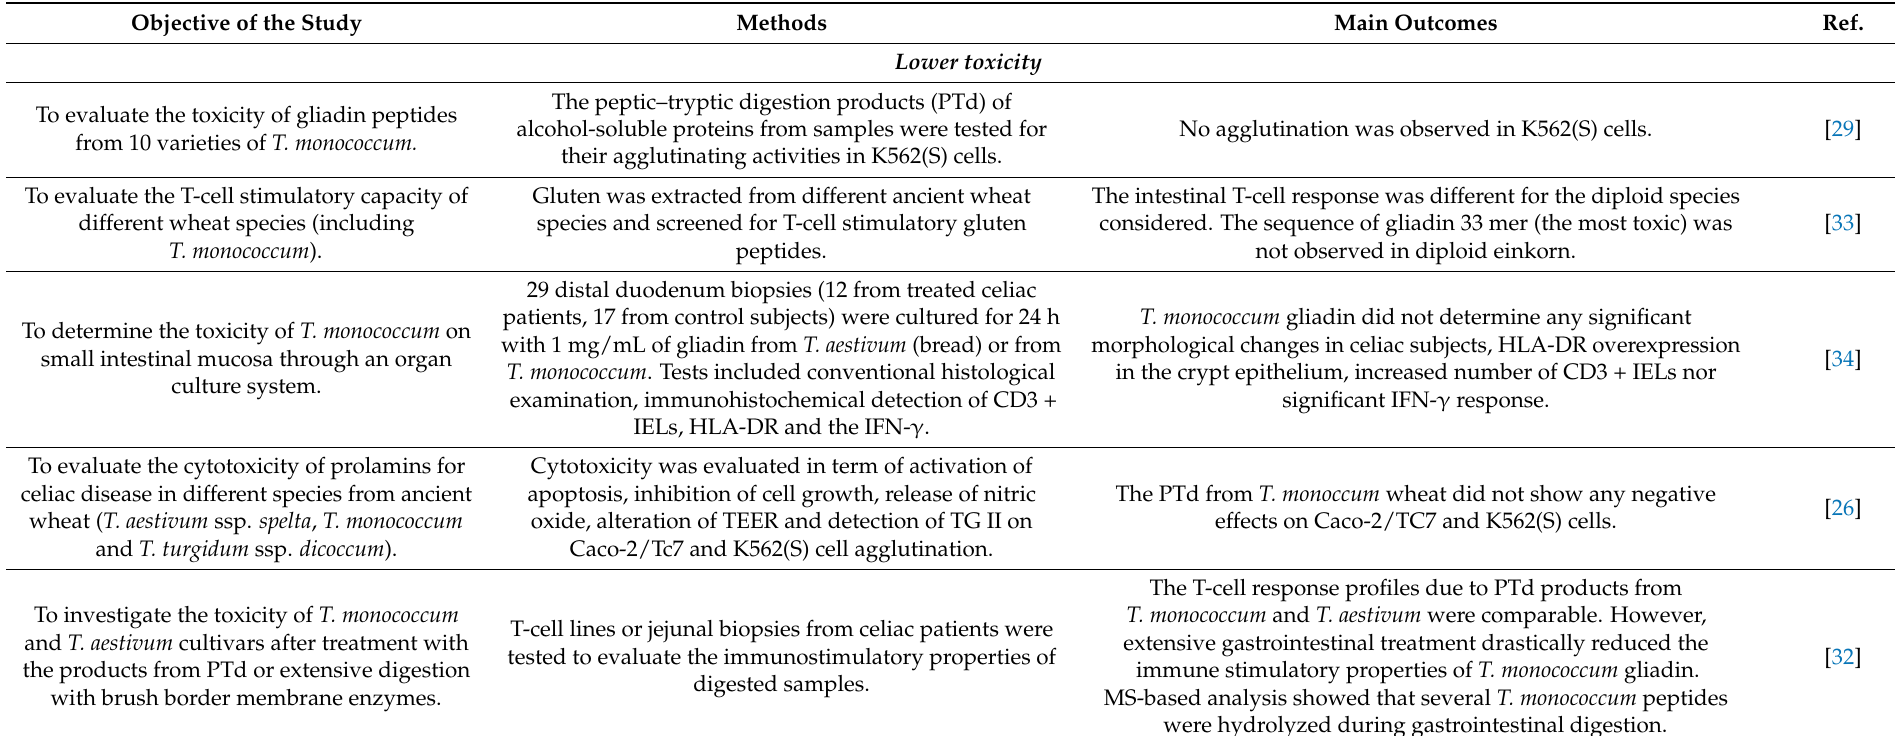
Table 4. In vitro and ex vivo studies to evaluate the toxicity of Triticum monococcum for celiac